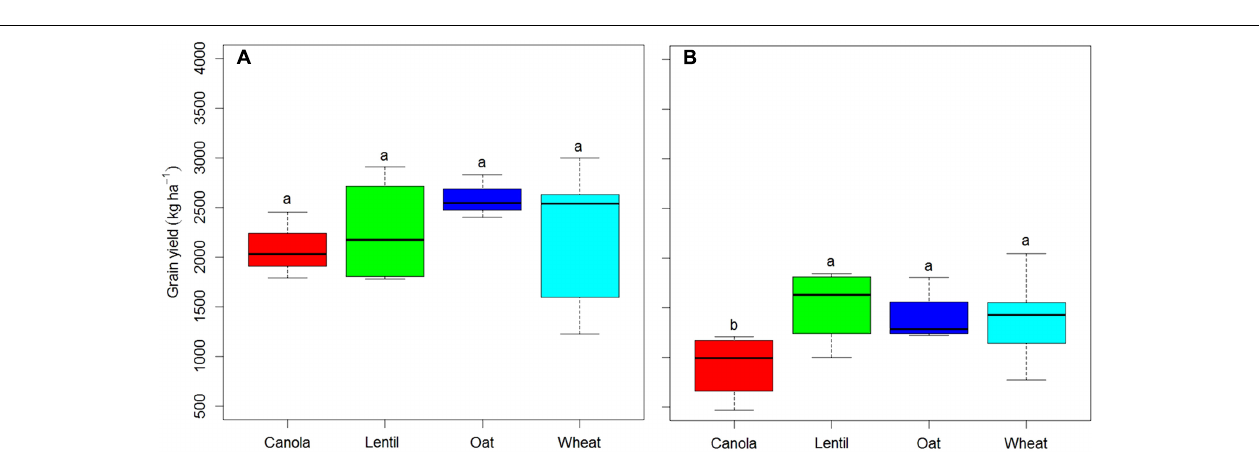
FIGURE 1 | Boxplot showing pea grain yield under various cropping systems in 2015 (A) and 2016 (B) at Indian Head, SK. Horizontal lines associated with boxes represent the median interquartile range; whiskers represent the range observed. Error bars with different letters indicate a significant difference at P < 0.05. Rotation sequence: WCOP, wheat-canola-oat- pea ; CWCP, canola-wheat-canola- pea ; WLOP, wheat-lentil-oat- pea ; WPCP, wheat-pea-canola- pea ; WPLP, wheat-pea-lentil- pea ; WPOP, wheat-pea-oat- pea . Italic pea in the rotation indicates pea sequence in each rotation. Same code applies to following figures, where applicable.